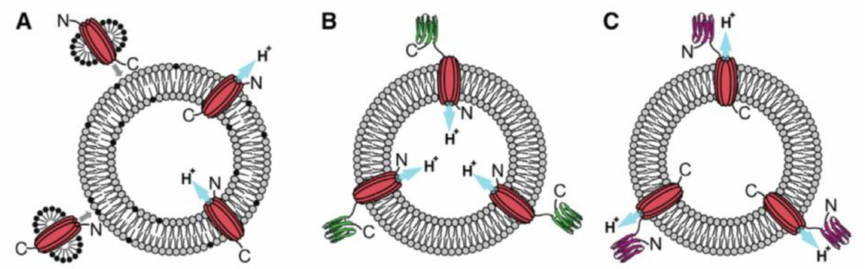
Figure 10. Control of the orientation of proteorhodopsin (PR) in liposomal membranes by artificial fusion to soluble proteins. ( A ) Unmodified PR was reconstituted into liposomes in random orientation. ( B ) With a C-terminally fused hydrophilic domain (in this case: green fluorescent protein), PR inserted into liposomes with the N-terminus pointing into the vesicle lumen. ( C ) If the N-terminus was fused to a water-soluble red fluorescent protein (mCherry) domain, PR inserted into the liposome in the opposite orientation and the C-terminus was pointing into the vesicle lumen. Reprinted